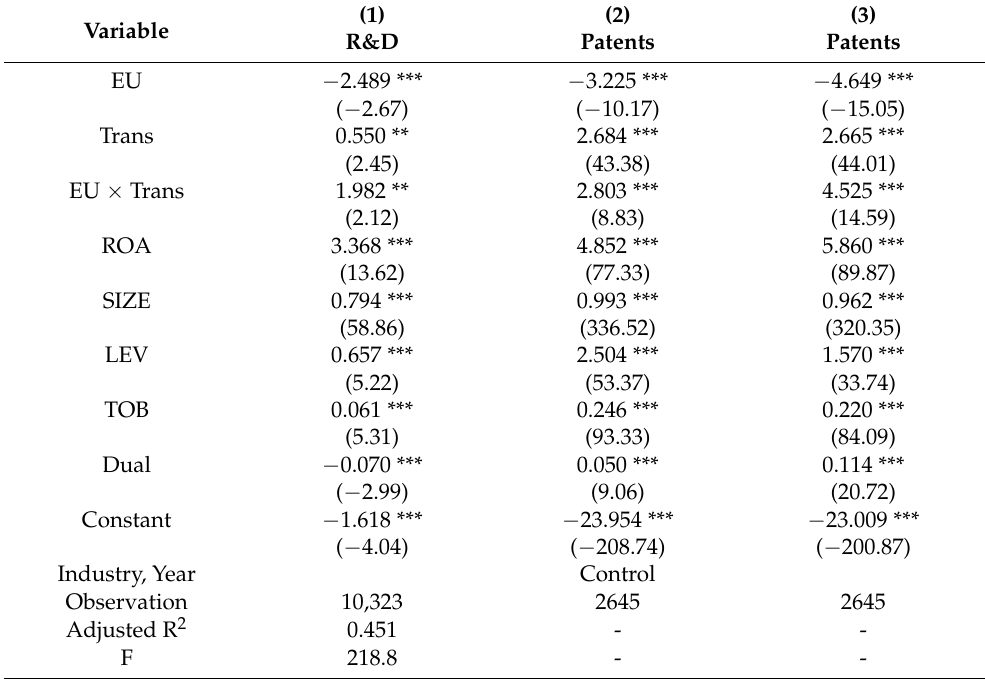
Table 7. The moderating effect of information transparency on environmental uncertainty and enterprise technological